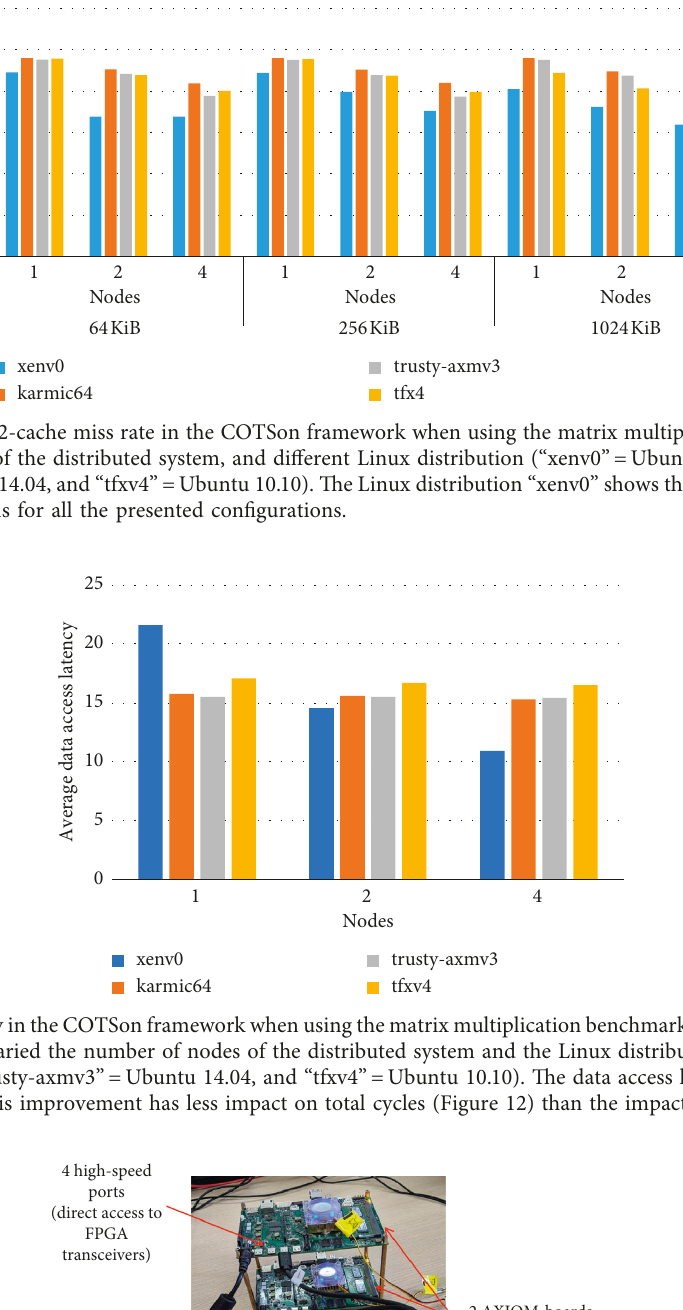
Ubuntu 16.04, (cid:31)